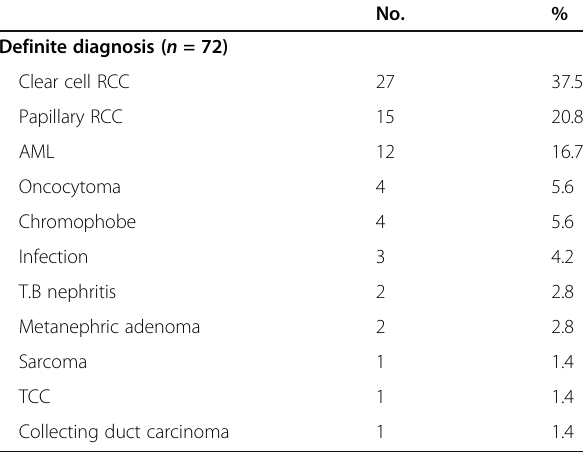
Table 1 The final diagnosis for the studied masses ( n = 72)